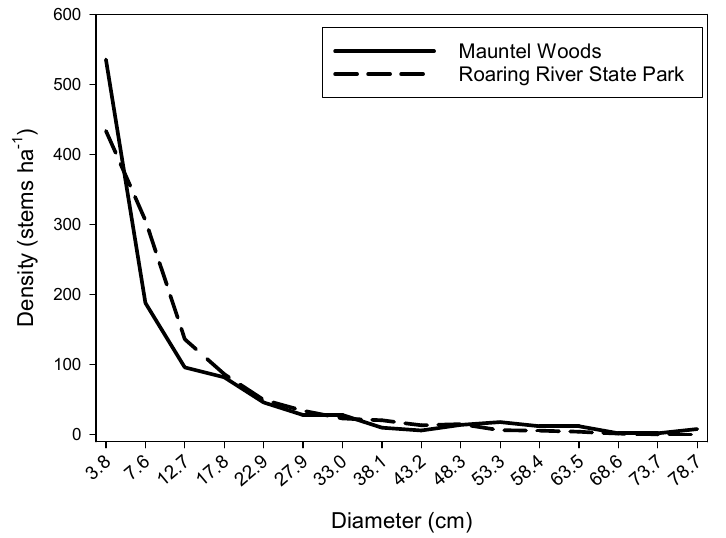
Figure 2. Comparison of the distribution of diameter classes on two dry-mesic old-growth forests, one at Roaring River State Park in Missouri and the other at Mauntel’s Woods in southern Indiana. Table 3. Age in years of large trees (dominant and codominant crown class) of representative dry- mesic old-growth oak forests.